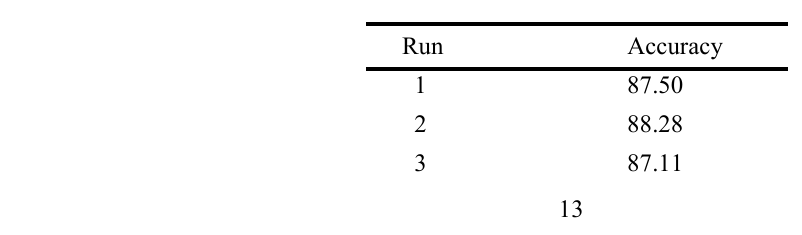
Table 3. Statistical Results of our